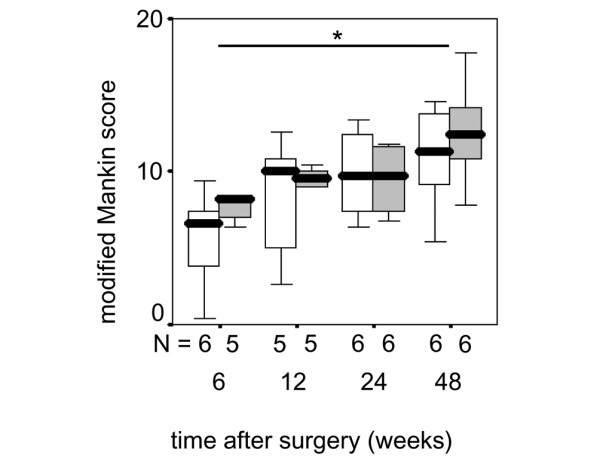
Box plot of histological grading in anterior cruciate ligament transection-treated knees at different times after surgery. Demonstrated are the median, standard deviation and interquartile range of the modified Mankin score data. White boxes, lateral tibial plateau; gray boxes, medial tibial plateau. * P < 0.05.